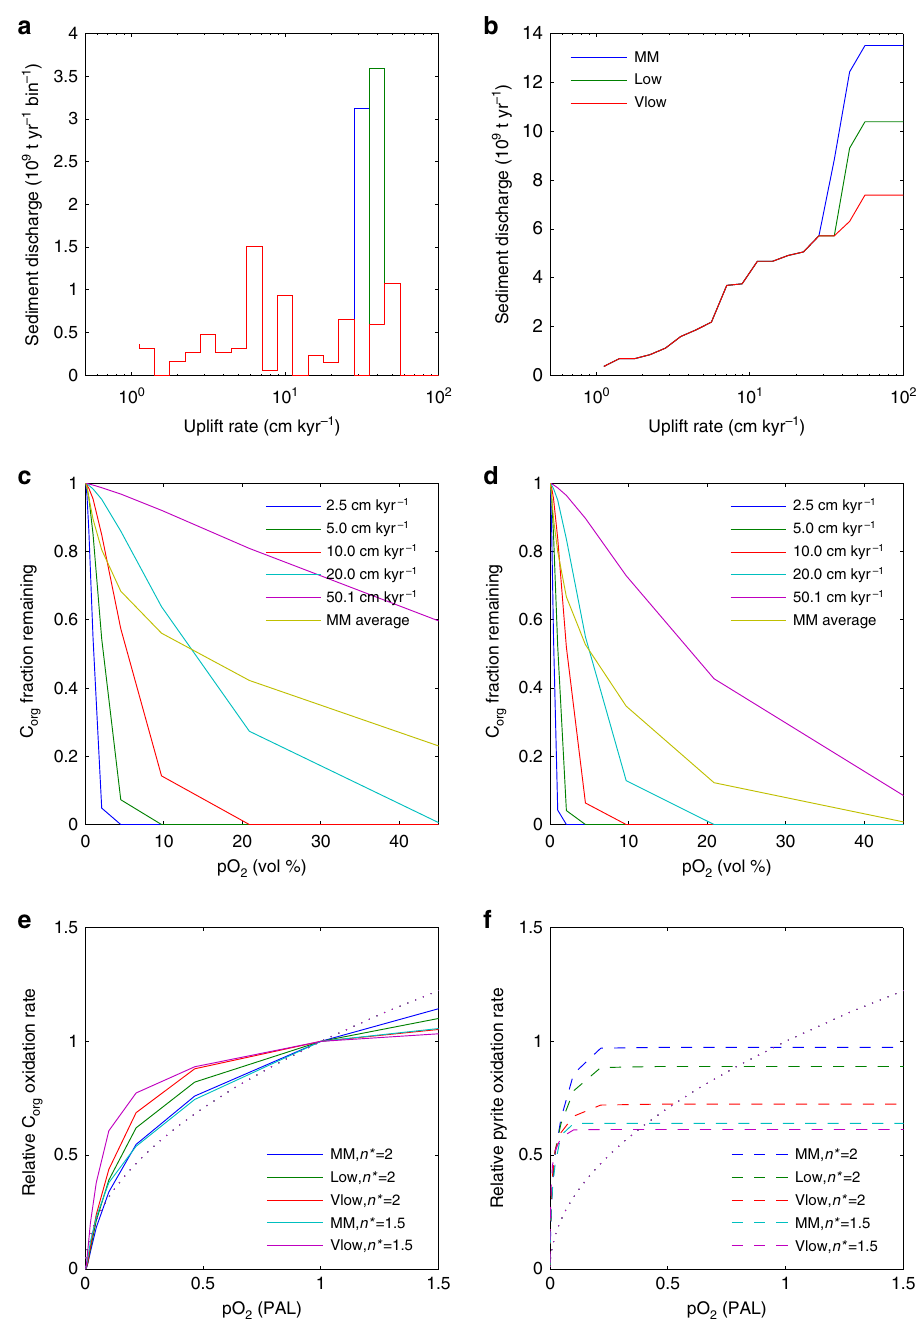
Figure 7 | Sensitivity analysis of oxidative weathering model. ( a ) Distribution of global sediment discharge rates from Milliman and Meade 44 (‘MM’) versus uplift rate (logarithmic bin width). Contributions from high-uplift regions SE Asia and Himalayas (blue) and oceanic islands (green) are identified. ( b ) Data as a showing cumulative global sediment discharge rate versus uplift rate and highlighting the large contribution to global total from high-uplift regions: global total (‘MM’; blue), omitting oceanic islands (‘low’; green), omitting SE Asia and Himalayas and oceanic islands (‘vlow’; red). ( c ) Fraction of organic carbon (C org ) remaining at surface as a function of atmospheric oxygen level for default shale model parameters ( n * ¼ 2), for a range of uplift rates (cmkyr (cid:2) 1 ), and for the land-surface average for modern distribution of uplift rates (‘MM average’). ( d ) As c , for increased shale oxygen diffusivity ( n * ¼ 1.5). ( e ) Sensitivity of oxygen dependence of global organic carbon oxidation rate to shale diffusivity ( n *, two values as for c , d ) and uplift rate distribution (as in a , b ). Key for uplift rate distribution: ‘MM’, modern global total; ‘low’, omits oceanic islands; ‘vlow’, omits oceanic islands and SE Asia and Himalayas. Dotted line shows (pO 2 ) 1/2 as assumed in some biogeochemical models. ( f ) As e , for global pyrite oxidation